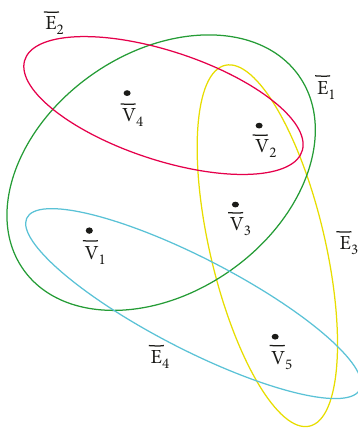
Figure 7: The complement H of IFHG H